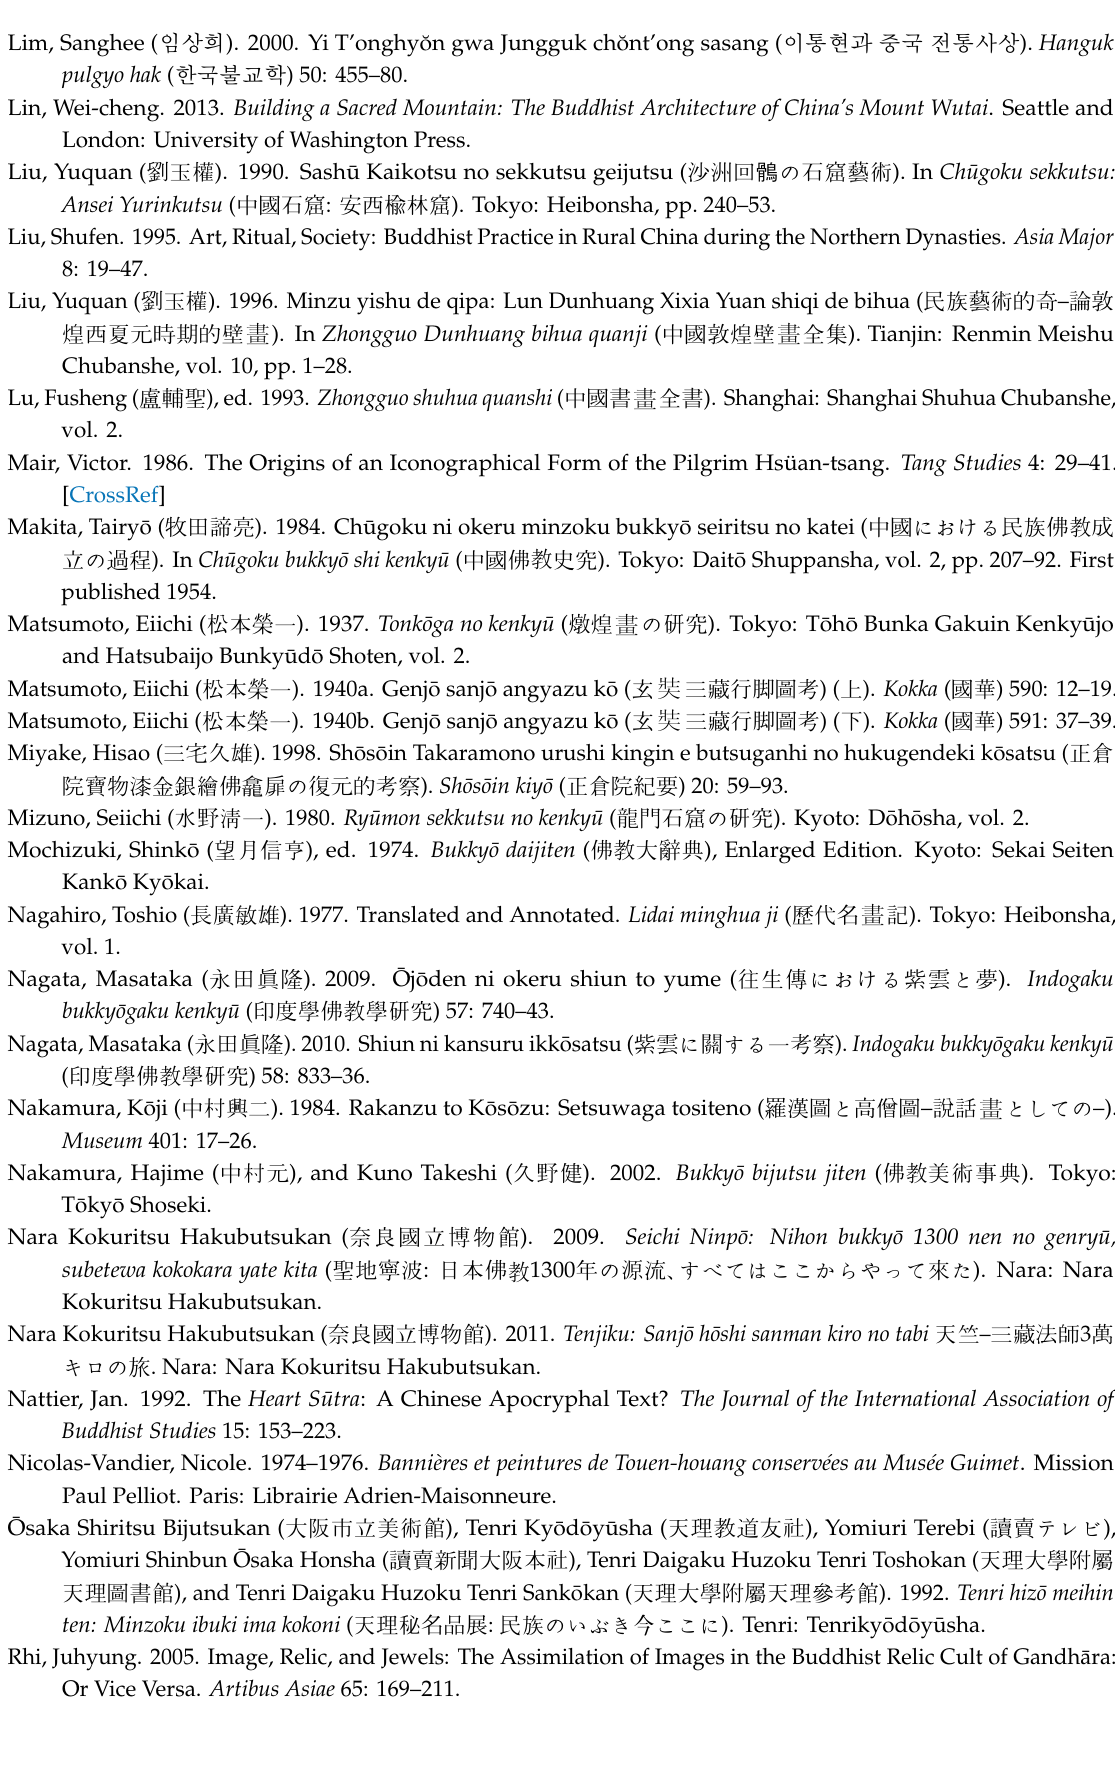
Figure 7. Itinerant Monk . Dunhuang, 10th century. Ink and colors on paper, 51.8 × 29. 3 cm. Inv. No. Photo by Leonard Kheifets. Figure 1. Itinerant Monk . Dunhuang, 10th century . Ink and colors on paper, 49.8 × 28.6 cm . National Museum of Korea.